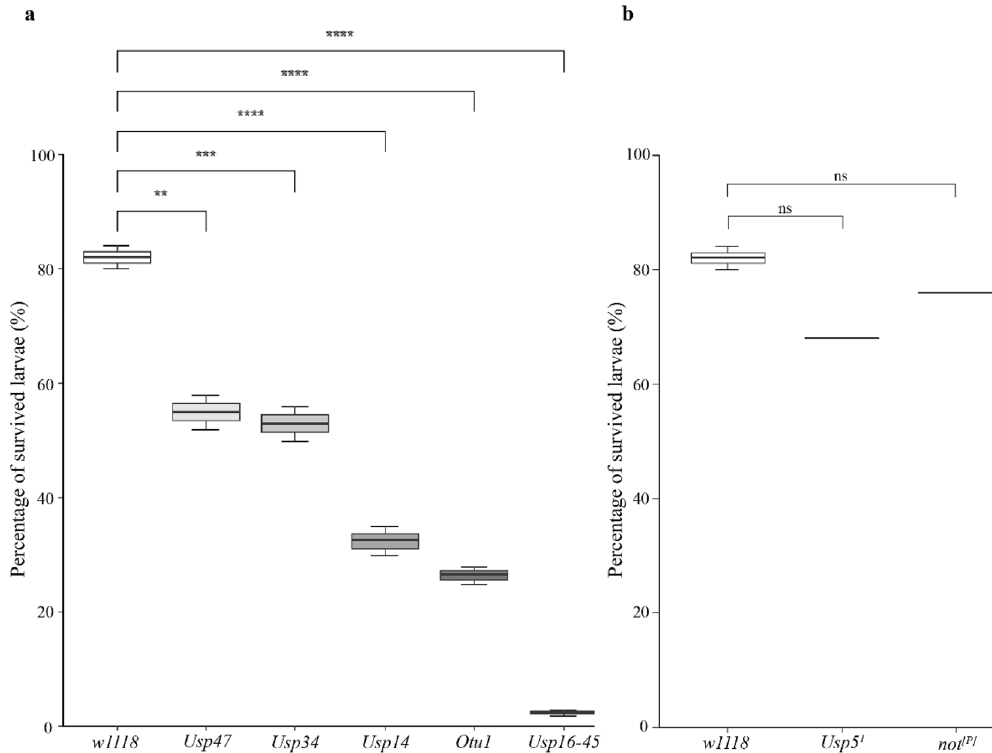
to 15 mJ/cm 2 UV. ( b ) Heterozygous Usp5 1 /TM6b GFP and not [P] /TM6b GFP DUB mutant, L3 larvae